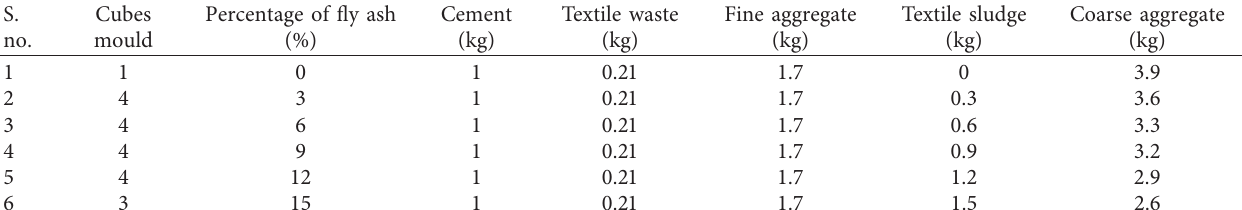
Table 2: Mix calculation of cubes.